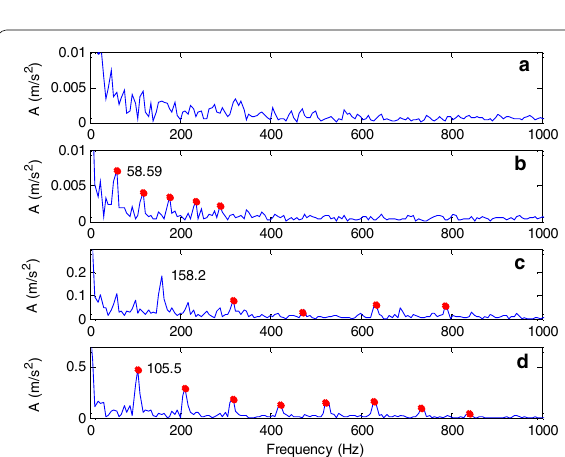
Figure 10 Hilbert envelope of 4 categories: ( a ) normal, ( b ) ball fault, ( c ) inner raceway fault, ( d ) outer raceway fault